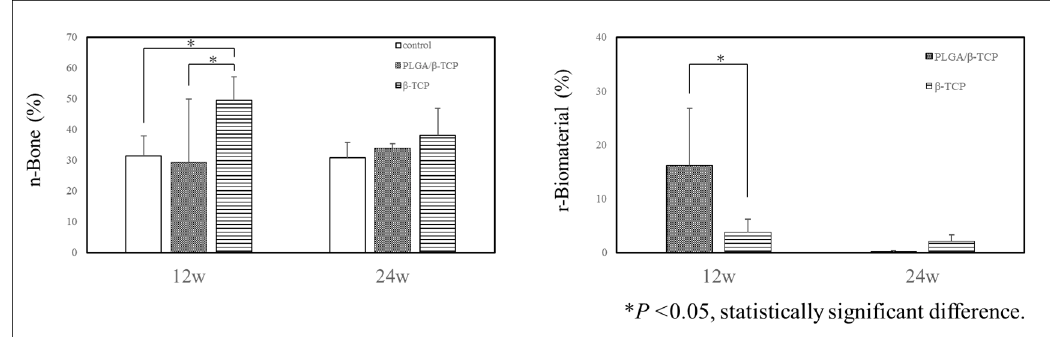
Figure 3. Quantitative histomorphometric analysis.